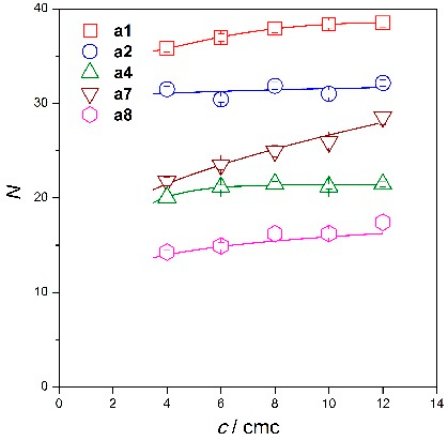
Figure 1. Micelle aggregation number N of plotted as a function of concentration c / cmc for spacer values s of diamide gemini surfactants a(s) . The solid curves are a guide to the eye. The fitting constant R from the fluorescence decay measurements and the aggregation number N of a(s) micelles calculated from Equation (2) in Section 3.2 are listed in Table 2 for all concentration values c / cmc and spacer values s . Table 2. Values of fitting parameter R , micelle aggregation number N of diamide gemini surfactants a(s) at the concentrations 4 × cmc to 12 × cmc , as determined from time-resolved fluorescence quenching measurements.